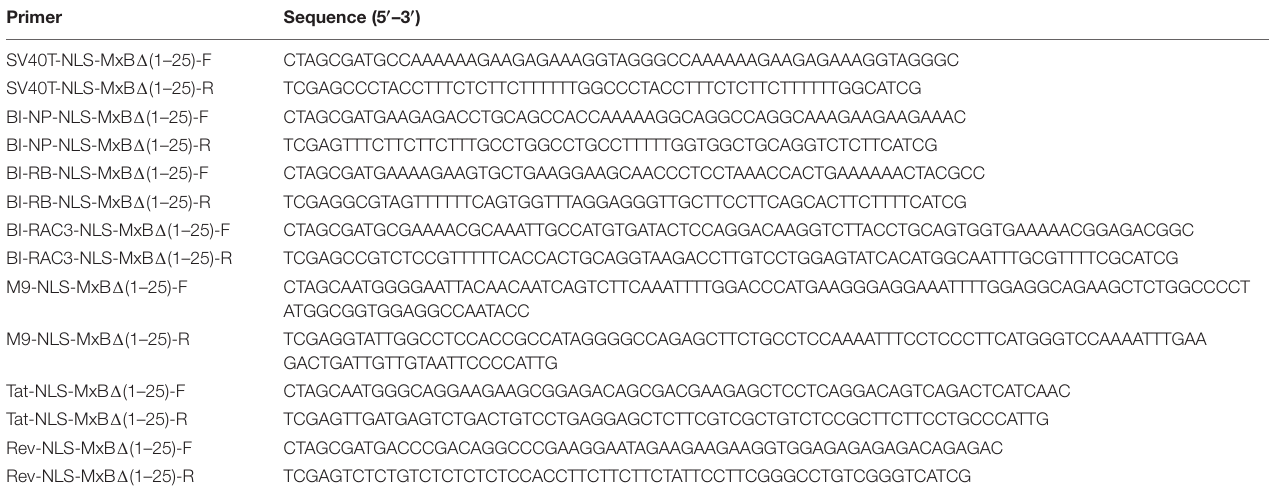
TABLE 1 | Primers for generating MxB mutants.